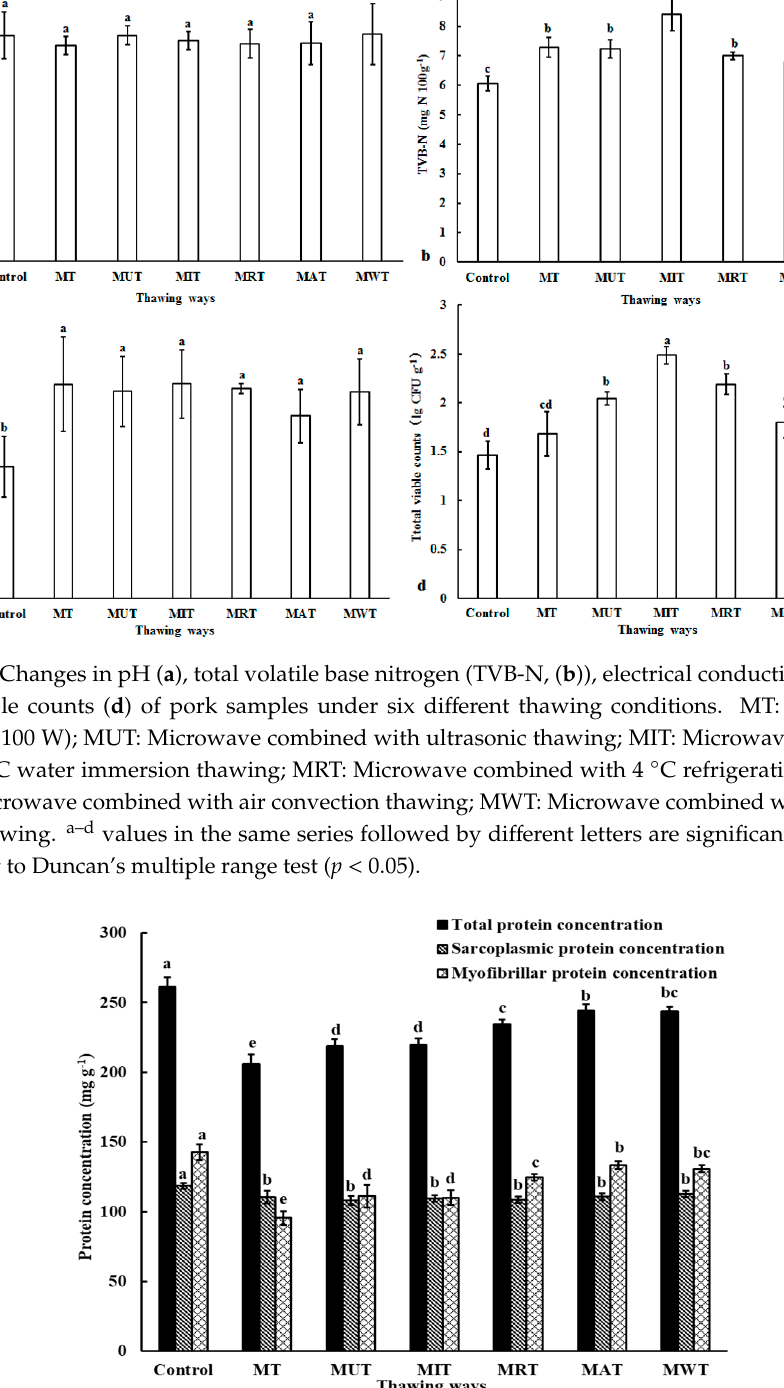
Figure 4. Changes in pork protein solubility under six different thawing conditions. MT: Microwave thawing (100 W); MUT: Microwave combined with ultrasonic thawing; MIT: Microwave combined with 35 °C water immersion thawing; MRT: Microwave combined with 4 °C refrigeration thawing; MAT: Microwave combined with air convection thawing; MWT: Microwave combined with running water thawing. a–d values in the same series followed by different letters are significantly different according to Duncan’s multiple range test ( p < 0.05).